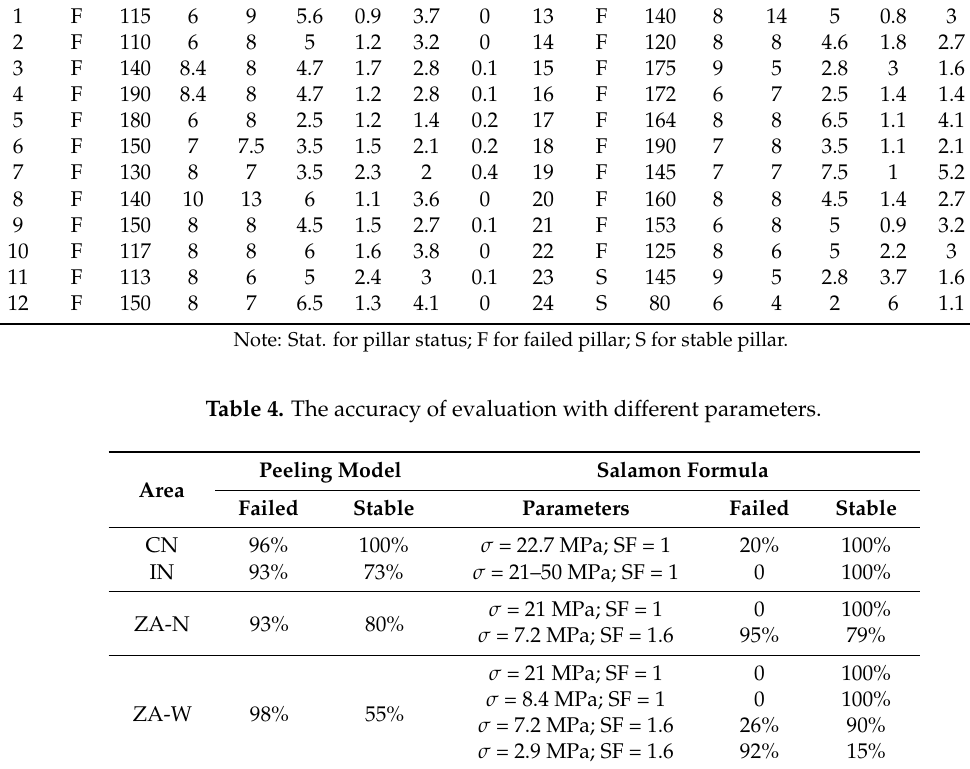
Table 3. The failed and stable pillar cases in the Yulin Mining Area in China. H No. Stat.